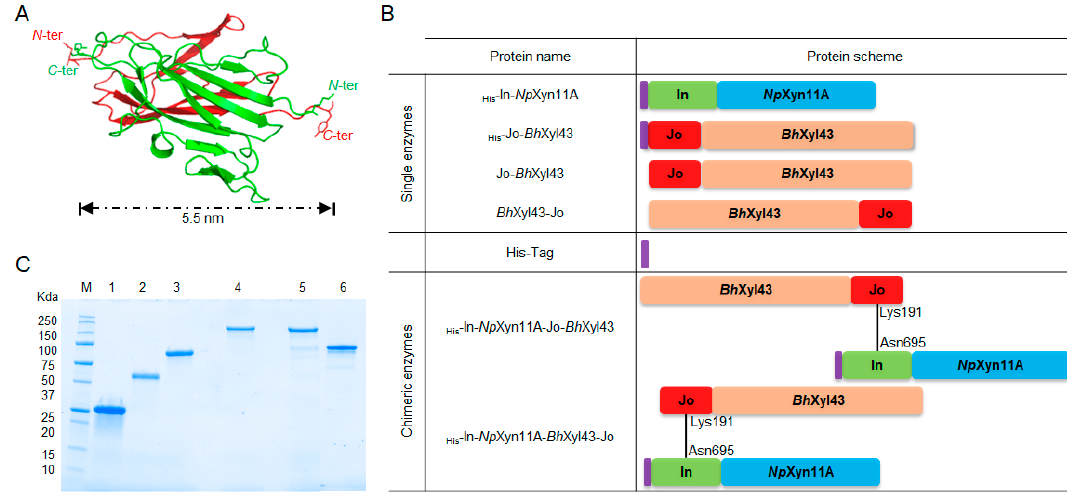
Figure 1. Expression and purification of the bi-modular enzymes. ( A ) Covalent association of Jo (red) and In (green) through the isopeptide bond of the Jo-Lys191 and In-Asn695 (black), displaying the head to tail orientation of the N- and C-termini (from PDB 5MKC). ( B ) Domain organisation of the Jo and In derivates of Np Xyn11A and Bh Xyl43, before and after the association through the Jo-In proteins. His-tag is in purple. ( C ) SDS-PAGE of the protein used in this study. Lanes: M, molecular mass markers; 1, His - Np Xyn11A; 2, His -In- Np Xyn11A; 3, His - Bh Xyl43; 4, His -In- Np Xyn11A-Jo- Bh Xyl43; 5, His -In- Np Xyn11A- Bh Xyl43-Jo; 6, His -Jo- Bh Xyl43 (image made from two SDS-PAGE, see Figure S8 for